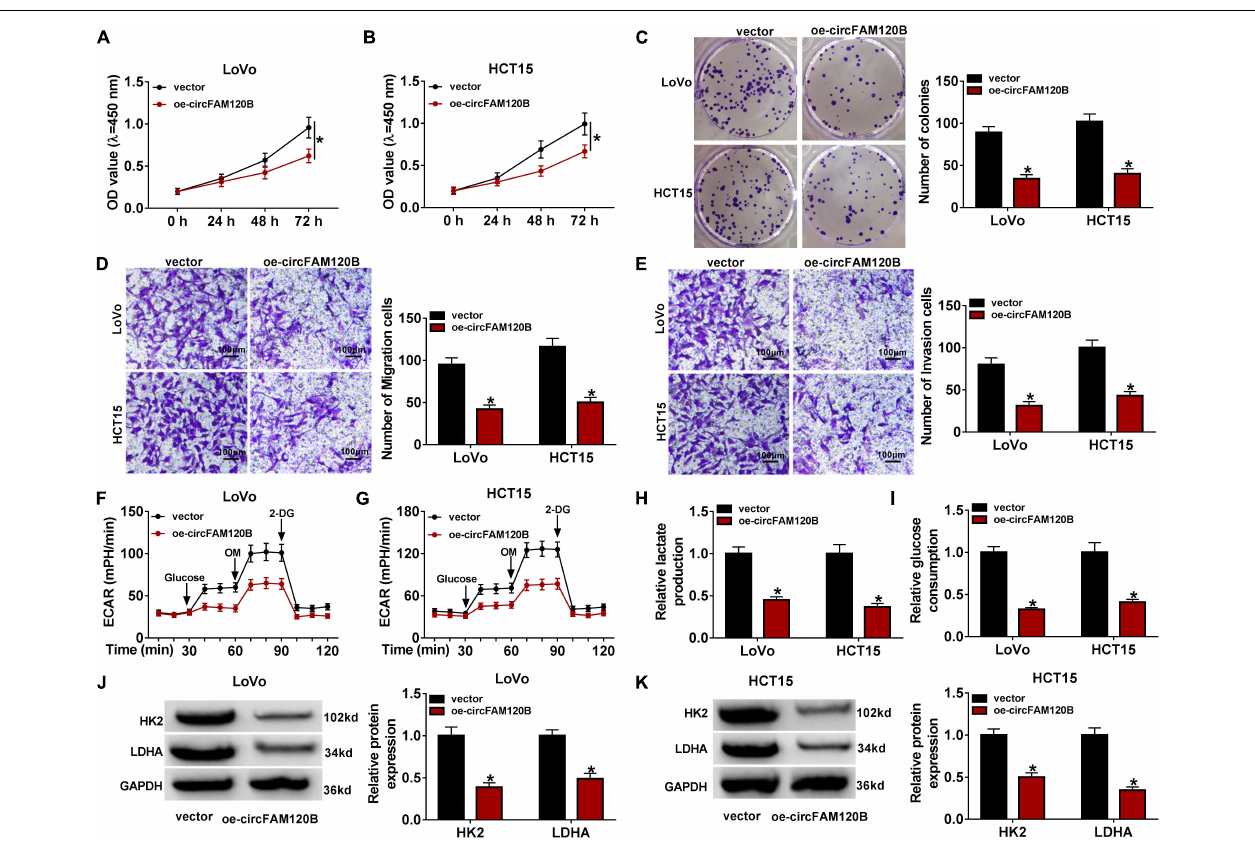
FIGURE 2 | CircFAM120B overexpression weakened cell proliferation, migration/invasion and glycolysis. In circFAM120B-overexpressed LoVo and HCT15 cells, (A–C) cell proliferation was assessed by CCK-8 assay and colony formation assay. (D,E) Cell migration and invasion were determined by transwell assay (magnification: 100 × ). (F,G) Extracellular acidification rate (ECAR) was measured by glycolysis stress test to evaluate glycolysis metabolism. (H,I) Lactate production and glucose consumption were quantified to assess glycolysis progression using corresponding kits. (J,K) Glycolysis-related markers, HK2 and LDHA, were quantified by western blot to observe glycolysis. * P <